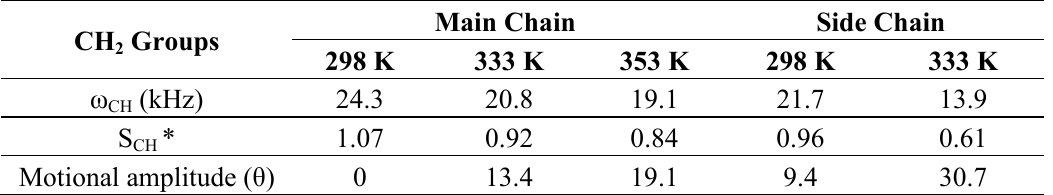
) of backbone and side-chain CH CH